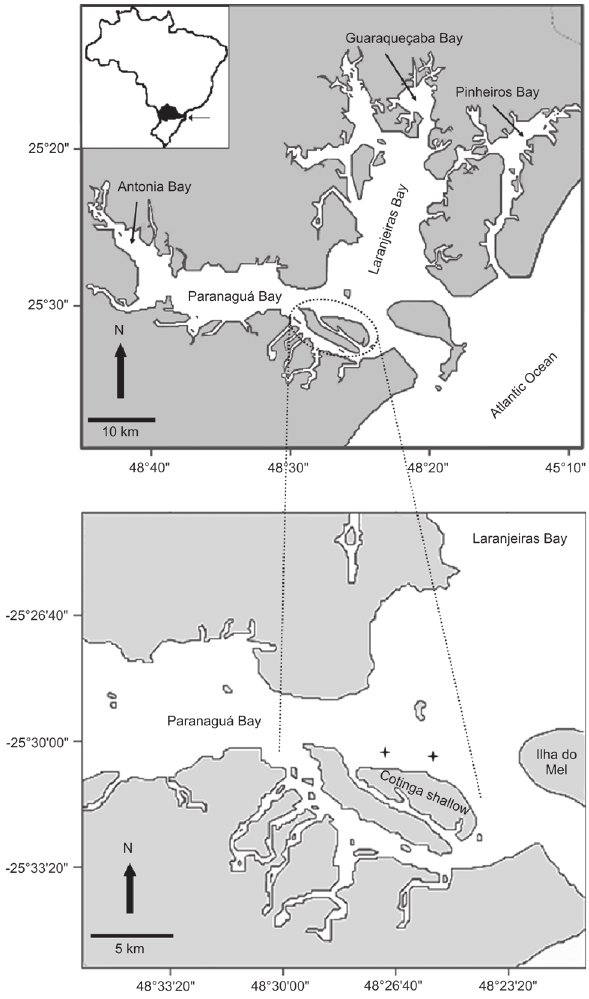
Figure 1. Map of the estuarine complex of Paranaguá, state of Paraná. The study area and the sampling sites are indicated in the detailed